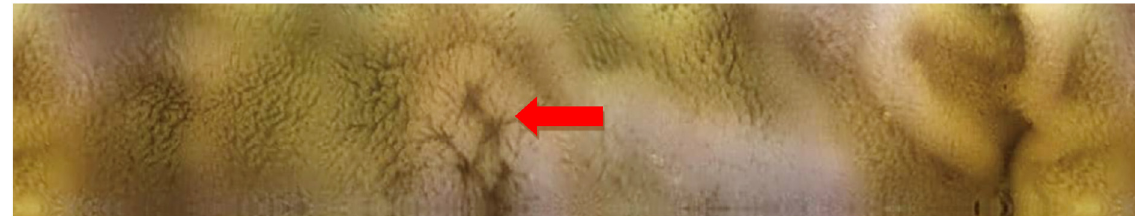
Figure 5. Video capsule enteroscopy. Peyer’s patches of the normal porcine ileum (arrow).